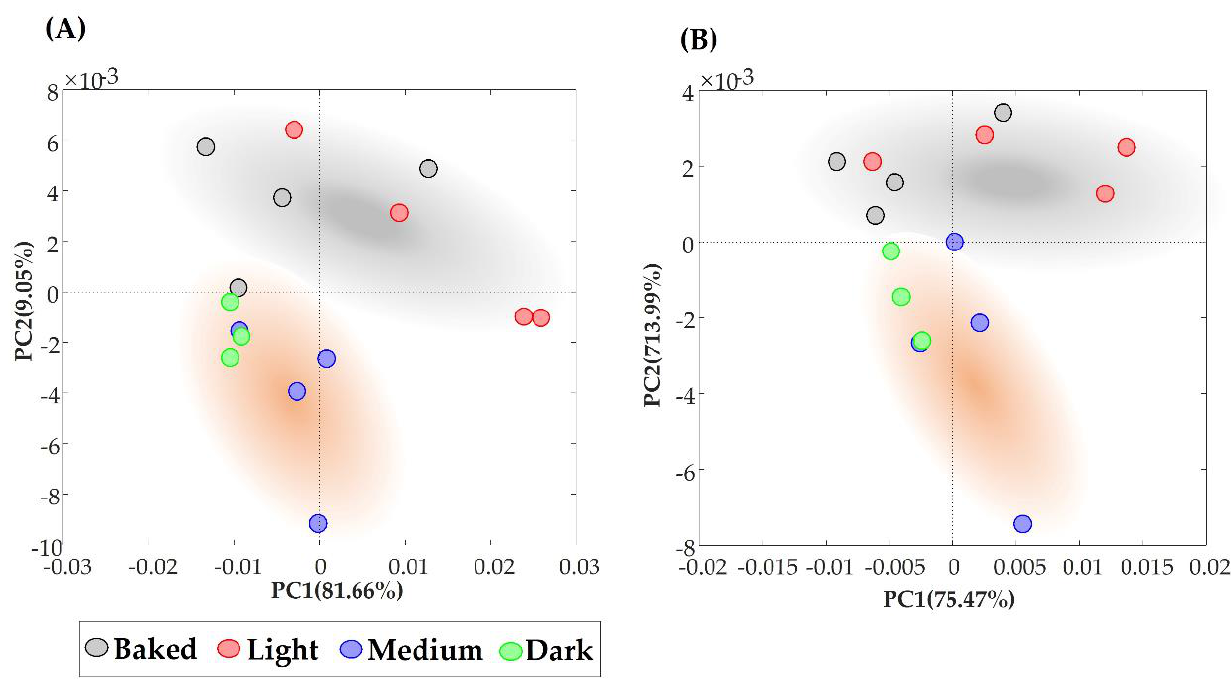
Figure 6. Interval Principal Component Analysis (iPCA) of the infrared spectra in the V ( A ) and VI ( B ) intervals, as shown in Figure 3. These spectra are from samples of coffee roasted in different roasting profiles (baked, light, medium, and dark) using two roasters (Probatino and Golden Plus).